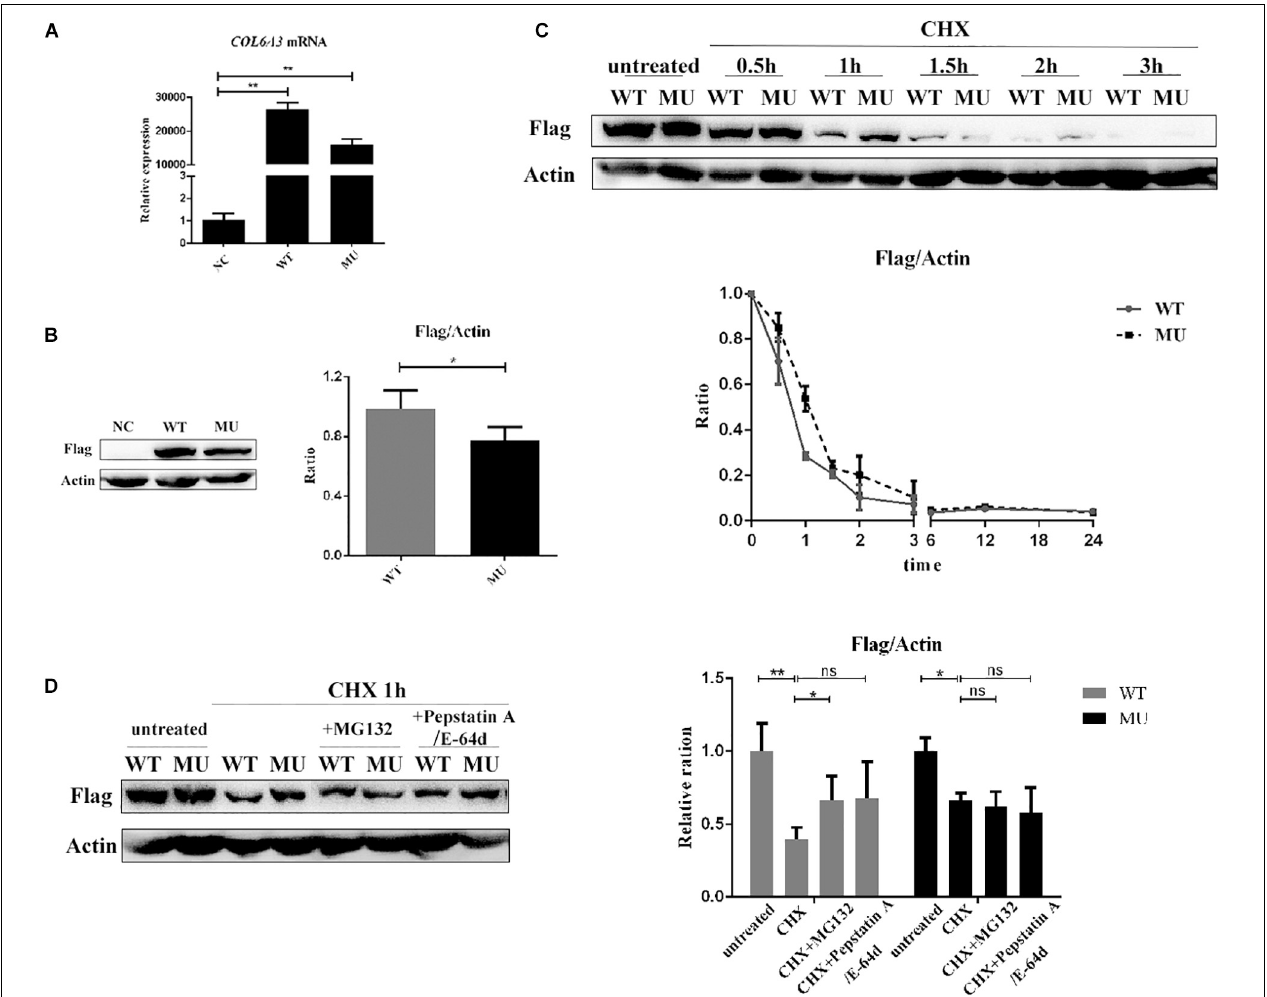
FIGURE 3 | The mutant COL6A3 protein was retained intracellularly. (A) Validation of the overexpression of wide-type or mutant COL6A3 in human corneal epithelial cell lines (HCECs) after transduction with lentiviral particles by RT-qPCR (WT vs un-transfected: P = 0.002; MU vs un-transfected: P = 0.004). The P -values were calculated by Student’s t-test for two group comparisons. (B) Validation of the overexpression of wide-type or mutant COL6A3 in human corneal epithelial cell lines (HCECs) after transduction with lentiviral particles by western blotting (WT vs MU: P = 0.020). The COL6A3 protein level of WT or MU cells was visualized using an anti-FLAG antibody. The P -values were calculated by Student’s t -test for two group comparisons. (C) WT and MU cells were treated with 5 µ g/mL cycloheximide (CHX) for 0.5, 1, 1.5, 2, and 3 h, respectively. Quantification of intracellular COL6A3 protein levels in WT or MU cells were determined by western blotting using an anti-FLAG antibody, and relative COL6A3 protein quantities were plotted and illustrated over time. (D) WT and MU cells were treated with 10 µ M Pepstatin A/E-64d or 10 µ M MG132, in the presence of 5 µ g/mL CHX for 1 h. The intracellular COL6A3 protein levels in WT or MU cells were determined by western blotting using an anti-FLAG antibody. The graphs showed quantification of intracellular COL6A3 protein from western blotting bands; values were the average with standard deviation obtained from three independent experiments (WT group: untreated vs CHX: P = 0.004; CHX vs CHX + MG132: P = 0.043; MU group: untreated vs CHX: P = 0.040). The P -values were calculated by one-way ANOVA test, followed by Bonferroni test. NC: the un-transfected HCECs. * P < 0.05, ** P < 0.01, *** P <